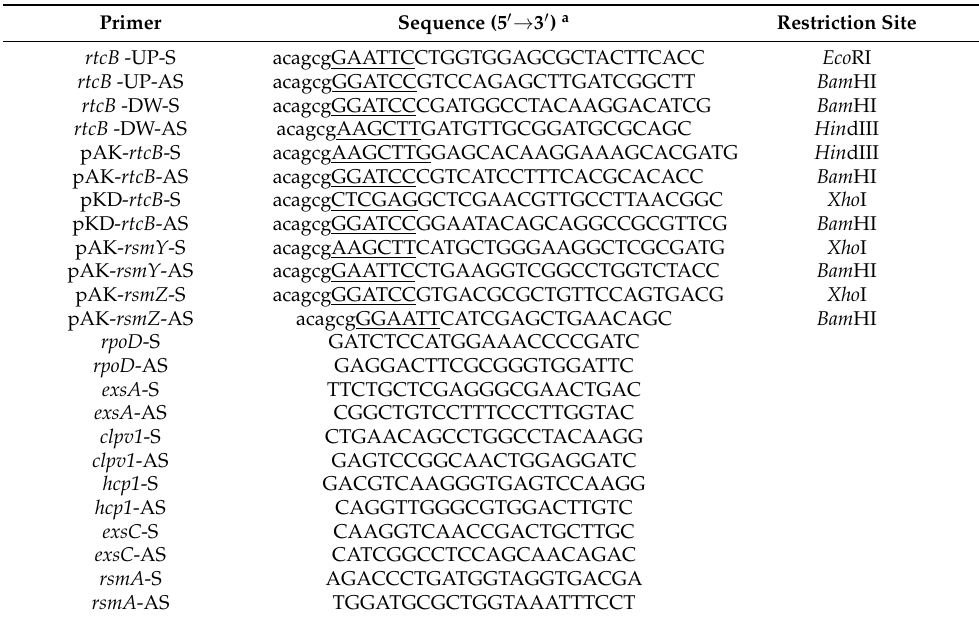
Table 3. Primers used in this